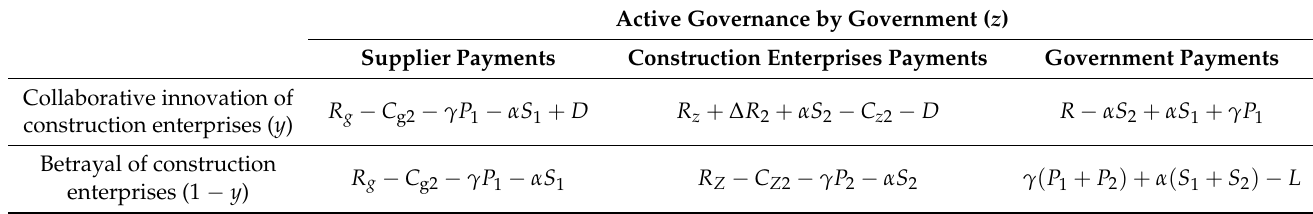
Table 3. The tripartite game payment matrix of supplier betrayal (1 − x ).